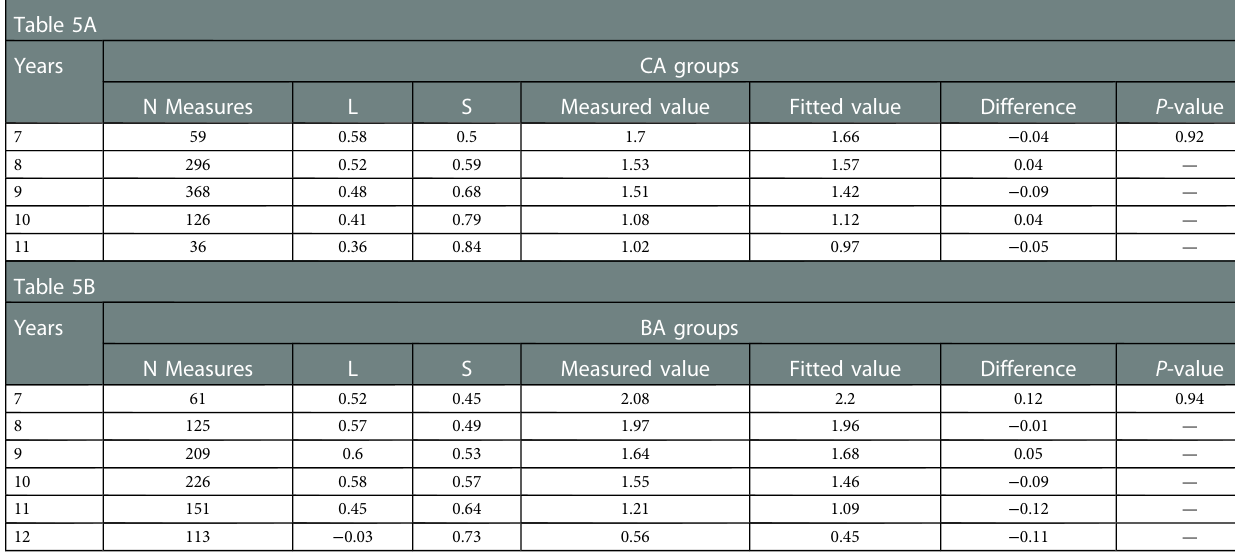
TABLE 5 Comparison between P50th Δ BA/ Δ CA of fi tted values and measured values . Table 5A Years CA groups